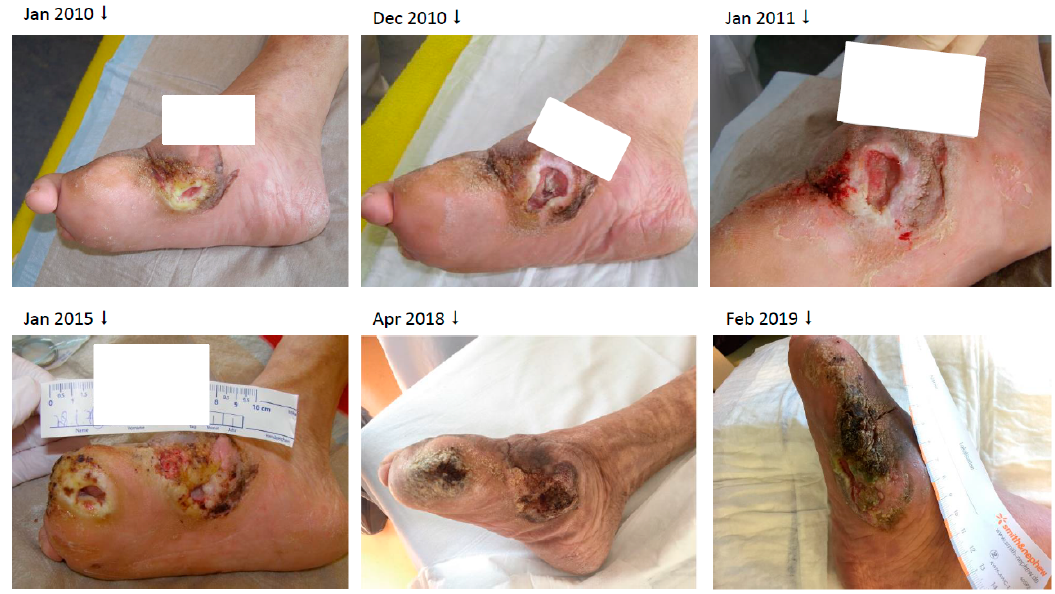
Figure 4. Chronic ulcer at the right feet and its variation during the years.